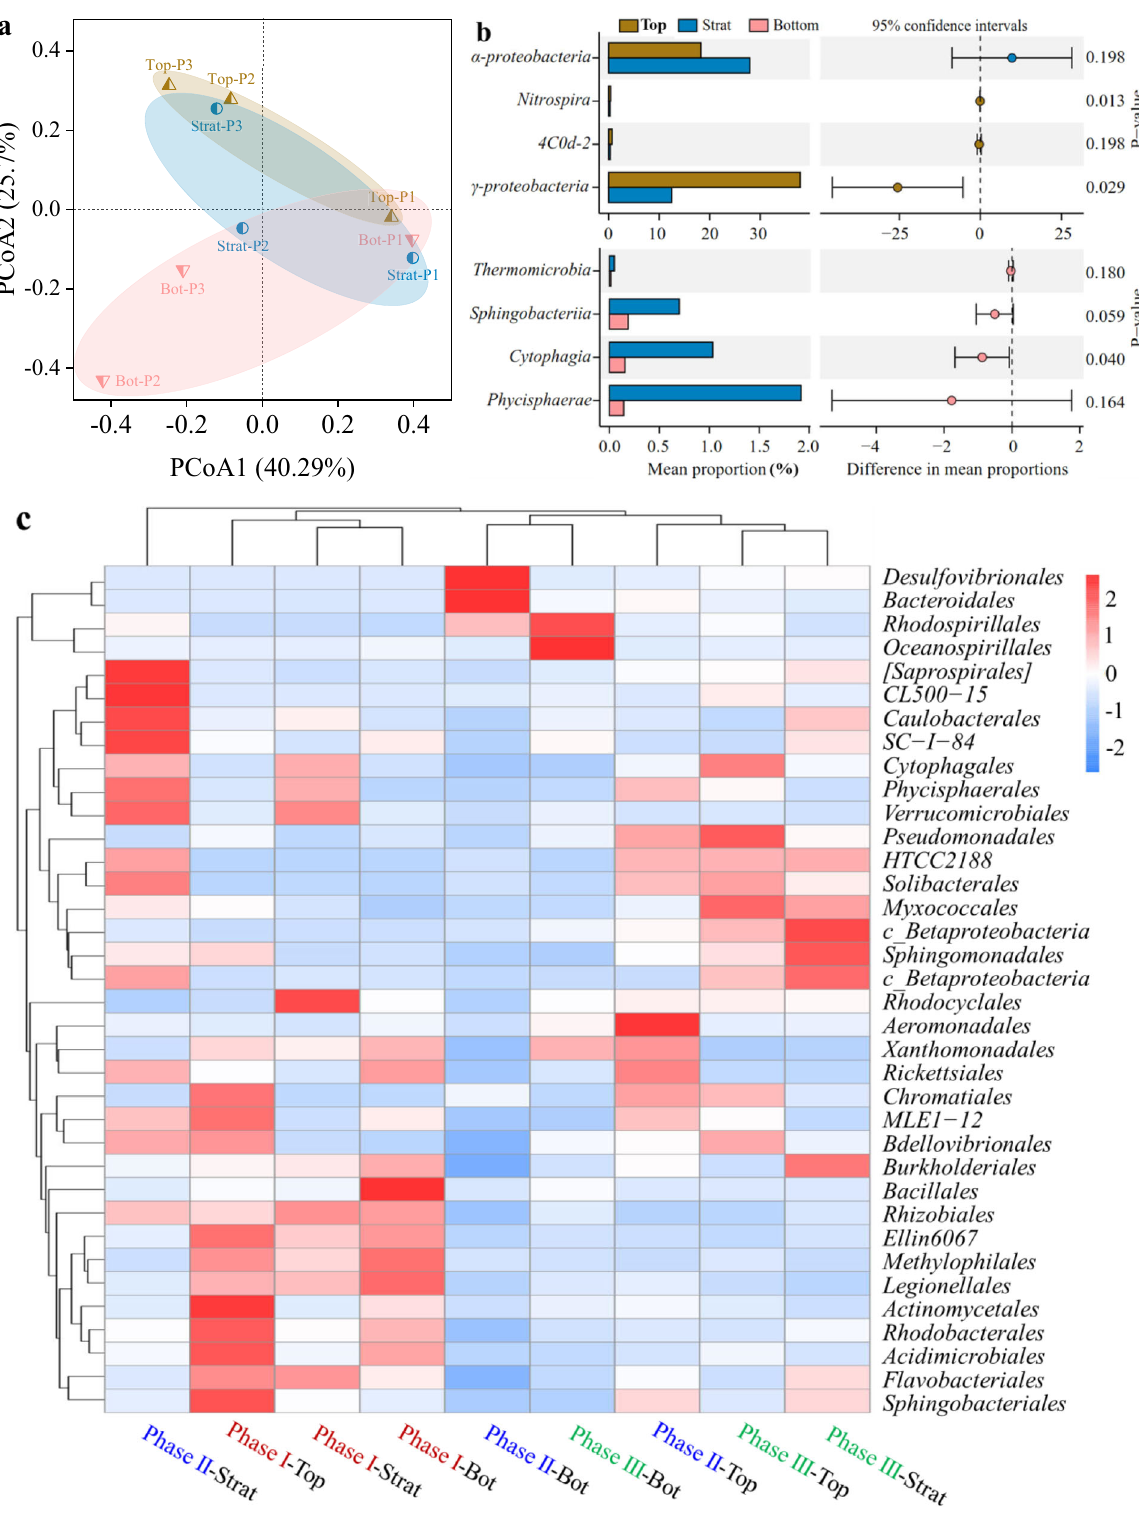
Fig. 4 Microbial communities. a PCoA of the Bray-Curtis distance of bacterial communities, b the statistically signi fi cant differences among the bacterial, and c the heatmap of the relative abundances of bacteria genera (>1% in any sample) at genus level at different reactor positions and operation Phases. Start and Bot are strati fi cation and bottom, respectively. One-way ANOVA was applied to evaluate the signi fi cance of the differences between